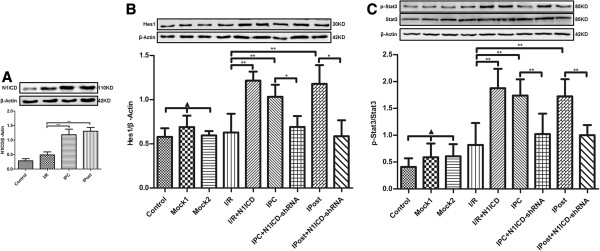
The activation of Notch signaling in langendorff-perfused isolated heart. A, N1ICD level was upregulated in IPC and IPost. B, Hes1 level was regulated by I/R, IPC and IPost with or without LV-N1ICD/LV-N1ICD-shRNA infection. C, The phosphorylation of Stat3 in different groups of myocardium. Data were presented as mean ± SD, n=3. Mock1 indicated the hearts infected with empty vector, Mock2 indicated the hearts infected with vector containing nonspecfic sequences. ▲P>0.05, *P<0.05, **P<0.01.